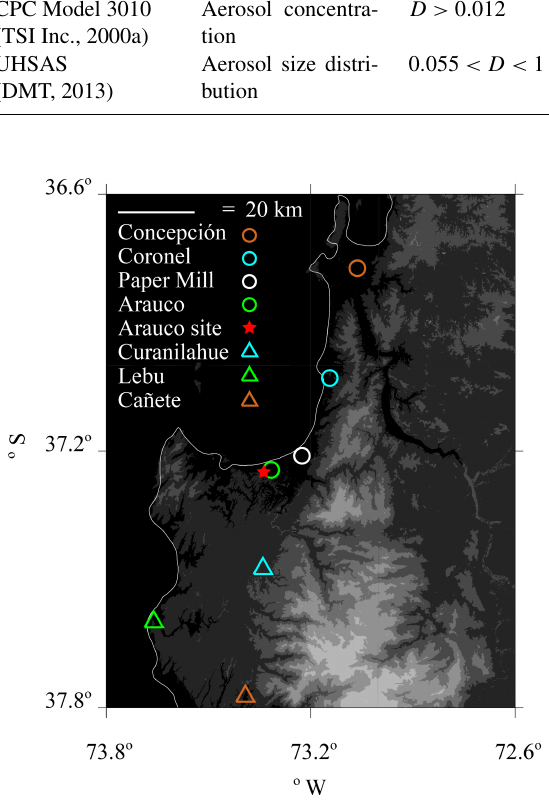
Figure 1. Central Chilean coastal region and the location of the Arauco site, where aerosol measurements were made during CCOPE. Altitude thresholds for the digital elevation map are at 0, 50, 250, 500, 750, and